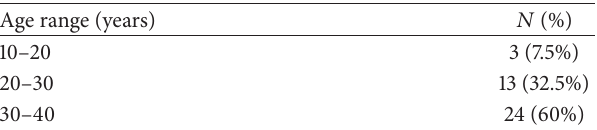
Table 1: Age distribution of patients.